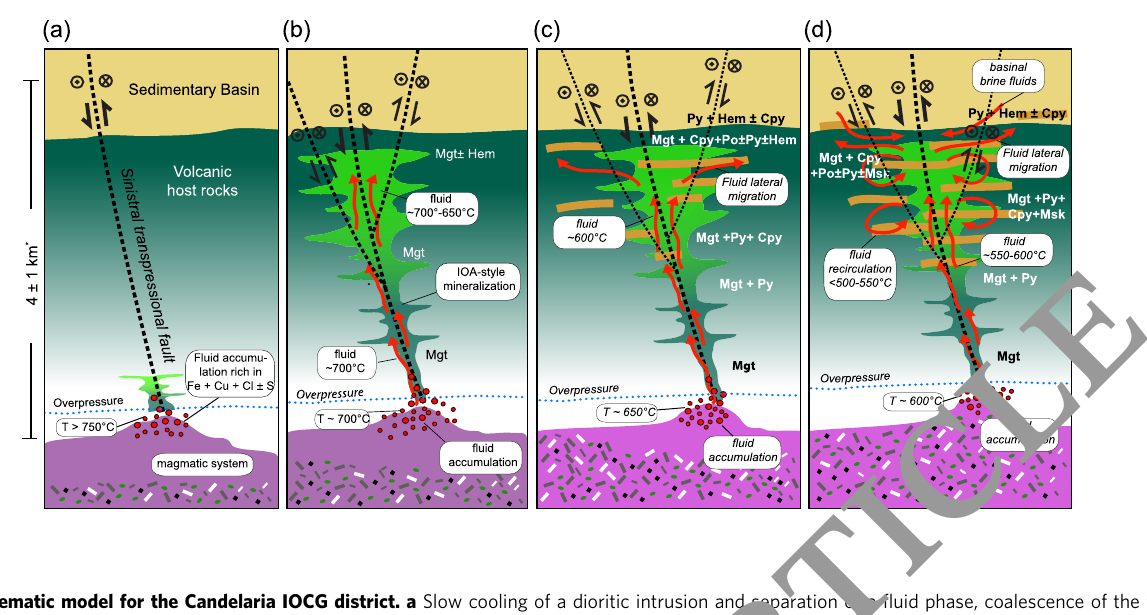
Fig. 4 Schematic model for the Candelaria IOCG district. a Slow cooling of a dioritic intrusion and separation of a fl uid phase, coalescence of the fl uid phase, and encapsulation of magnetite microlites to form a magnetite- fl uid suspension accumulation under overpressure conditions that scavenges Fe, Cu, Au, S, and Cl 57, 58 . b The accumulated fl uid is sporadically “ tapped ” by active, deep crustal sinistral strike-slip faults initially associated with the formation of the sedimentary basin. Fault movement allowed the ascent of high-temperature Fe-rich fl uids. c Further fault movement would allow the ascent of (Cu, Fe)-rich fl uids; Cu in the fl uid increases due to increased solubility of CuCl at ~650 °C. d Fluids cooling to temperatures of about 600 °C; further cooling to ~500 °C of the ascending hydrothermal fl uids by convection causes Cu precipitation. Peak chalcopyrite mineralization occurs at temperatures of ~400 °C. At the fi nal stage, hydrothermal fl uids would have interacted with external, basin derived fl uids, which would have added reduced sulfur into the system in the form of pyrite but no important Cu mineralization 20 . *Depth estimated for pressure conditions of 100